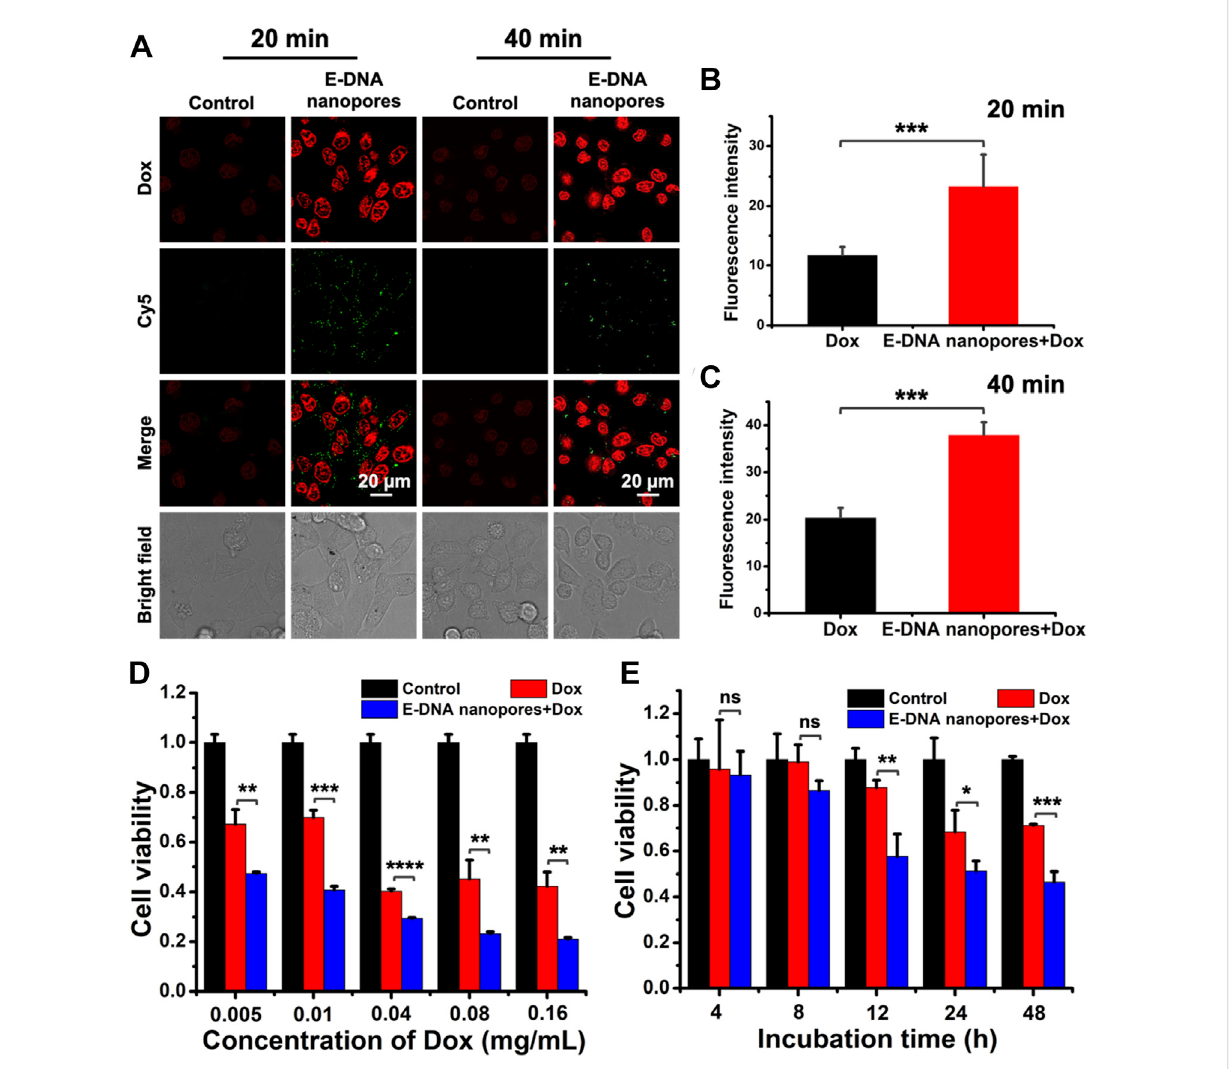
FIGURE 5 (A) Confocal images of MCF-7 cells inserted with DNA nanopores and incubated with Dox at 37 ° C for a different time. Scale bar: 20 μ m. (B – C) The statistic of average fl uorescence intensity of Dox in each cell with different incubation times ( n = 40). *** indicates p < 0.001. (D) Cell viability of MCF-7 cells incubated with different concentration of Dox for 40 min and then incubated at 37 ° C for 48 h without extra Dox ( n = 3). ** indicates p < 0.01. *** indicates p < 0.001. **** indicates p < 0.0001. (E) Cell viability of MCF-7 cells incubated with 0.15 mg/ml Dox for 40 min and then incubated at 37 ° C for different time without extra Dox ( n = 3). ns indicates no signi fi cant difference. * indicates p < 0.05. ** indicates p < 0.01. *** indicates p <